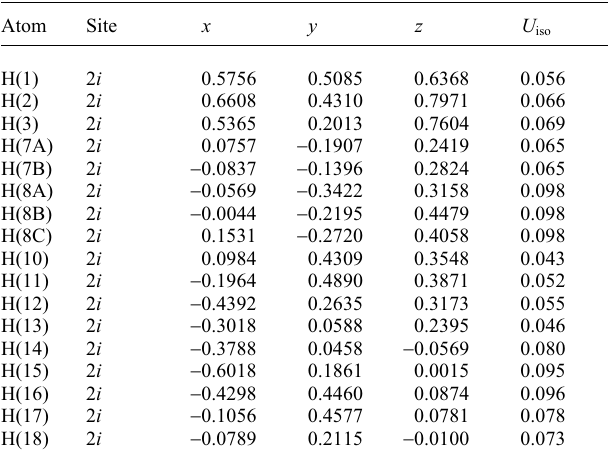
Table 2. Atomic coordinates and displacement parameters (in Å 2 )